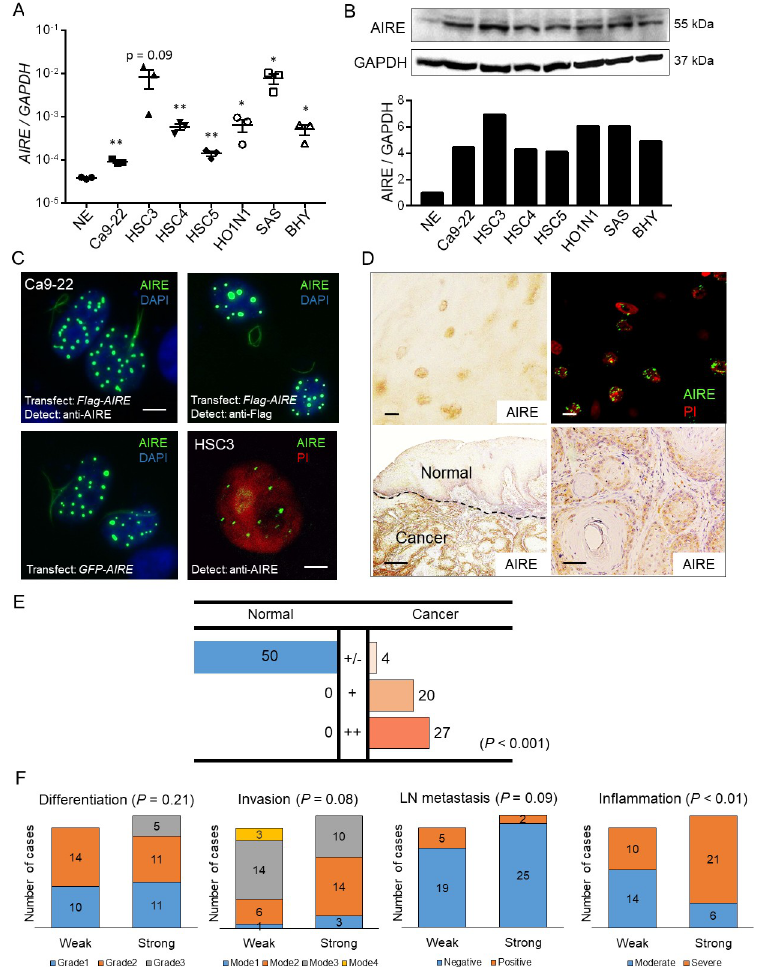
Fig 2. AIRE expression in OSCC. A) Real-time RT-PCR analysis of various cancer cell lines. NE: normal epithelium from gingiva. GAPDH was used for normalization. Data are shown on a logarithmic scale as the mean ± SEM of technical triplicates. � P < 0.05, �� P < 0.01 by Student’s t -test. B) Upper panel: Western blot analysis of cancer cell lysates using anti-AIRE antibody. GAPDH was used as a loading control. Lower panel: Densitometric quantification of the western blot data. NE: normal epithelial primary cultured cells derived from neonatal foreskin. C) Nuclear localization of AIRE in cultured cells. Upper left and right panels: Ca9-22 cells were transfected with Flag-AIRE . The cells were fixed and subjected to immunofluorescence staining. Lower left panel: Ca9-22 cells were transfected with GFP-AIRE . The cells were examined under ultraviolet light. Lower right panel: endogenous AIRE in the nucleus of an HSC3 cell as revealed by immunofluorescence staining using laser scanning microscopy. PI: propidium iodide. Scale bar: 10 μ m in upper left panel, 5 μ m in lower right panel, scale bars were omitted in upper right and lower left panels. D) Representative images of immunohistochemical staining of AIRE in OSCC tissue specimens. Upper left, lower left, lower right panels: chromogenic detection using DAB. A representative negative-control image using nonspecific mouse IgG instead of anti-AIRE antibody is shown in S2 Fig. Upper right panel: fluorescence detection. Scale bar: 10 μ m (upper left, upper right), 500 μ m (lower left), 50 μ m (lower right). E) Summary of immunohistochemical evaluation of AIRE in OSCC tissue specimens. Expression was compared between normal squamous epithelium and cancer in the same specimen and was scored as +/–: no upregulation in cancer; +: upregulation in cancer; ++: strong upregulation in cancer. Mann-Whitney U test. F) Comparison of AIRE expression with clinicopathological parameters (Mann-Whitney U test). “Weak” refers to cases with the score +/–or + in E), “strong” refers to the cases with score + + in